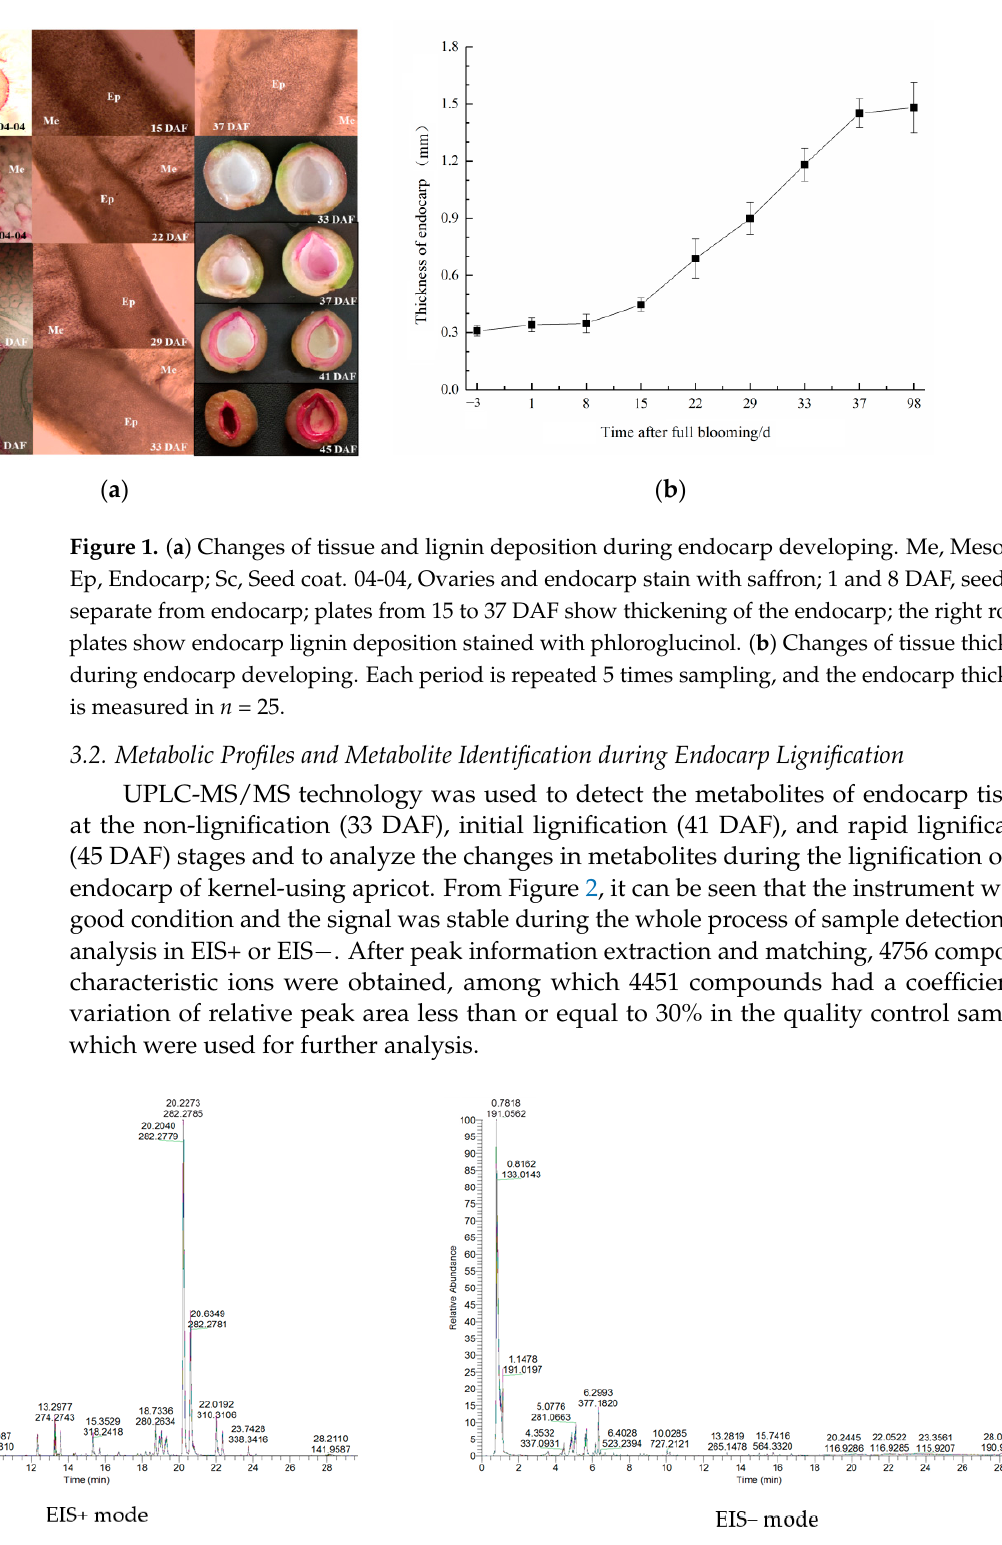
Figure 2. UPLC-MC profiles of metabolites in the apricot endocarp.